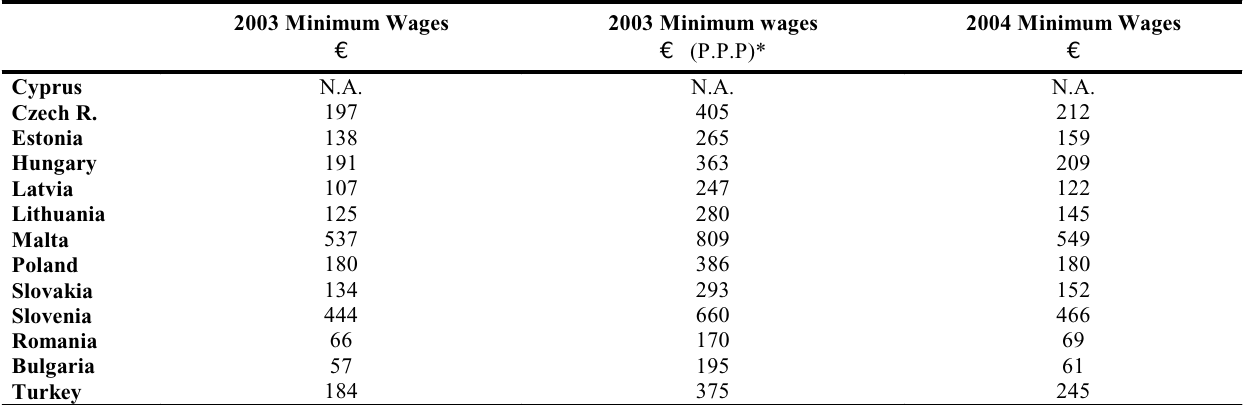
Table 10 . Comparison of Turkey with Romania, Bulgaria and the 10 new members of the EU in terms of minimum